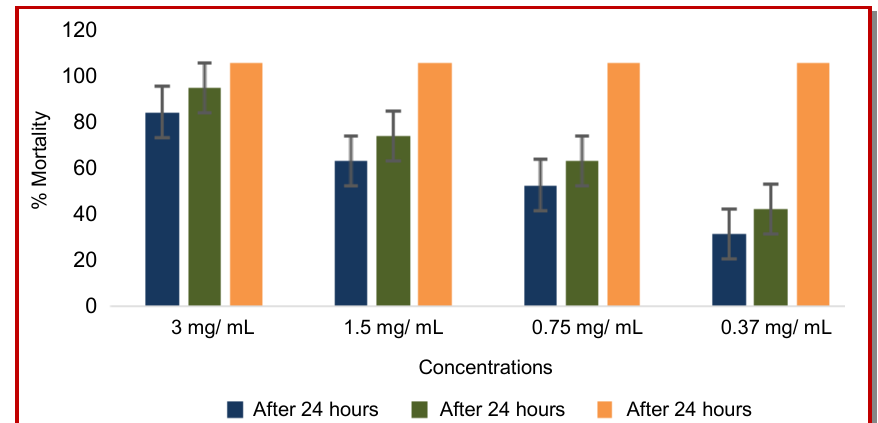
Figure 1: Cytotoxic effects of Cyperus scariosus methanolic extract (%